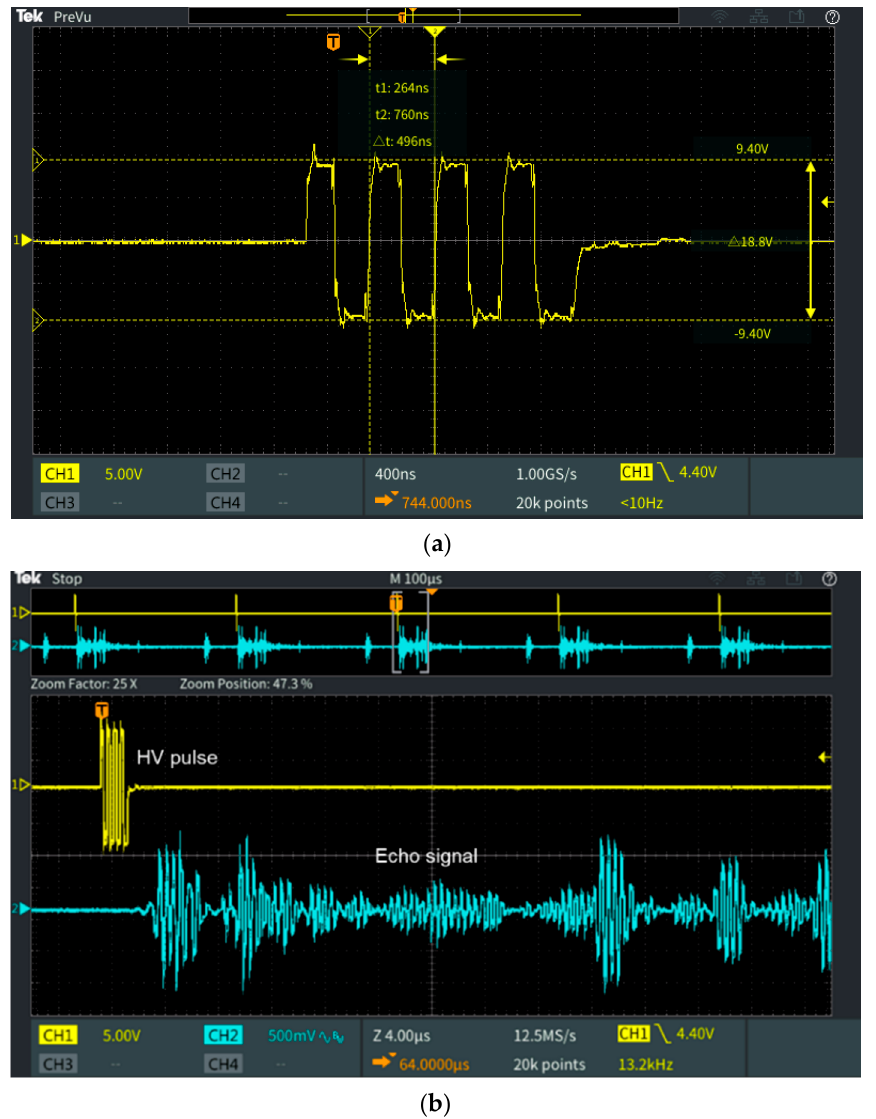
Figure 15. Measurement analog waveforms of ( a ) high-voltage pulser output and ( b ) echo signal from commercial phantom model.